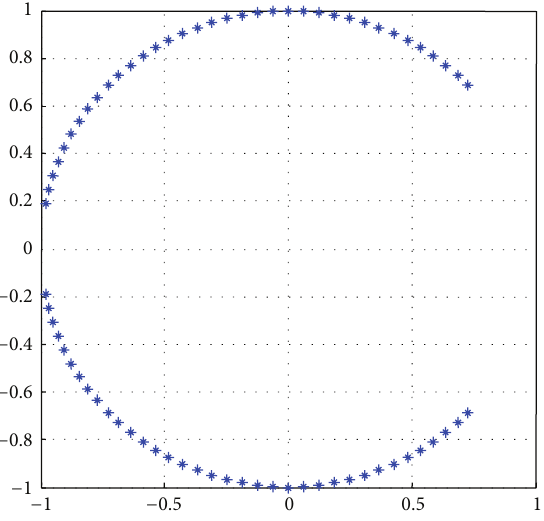
Figure 17: Reached attitude of 𝑃 .